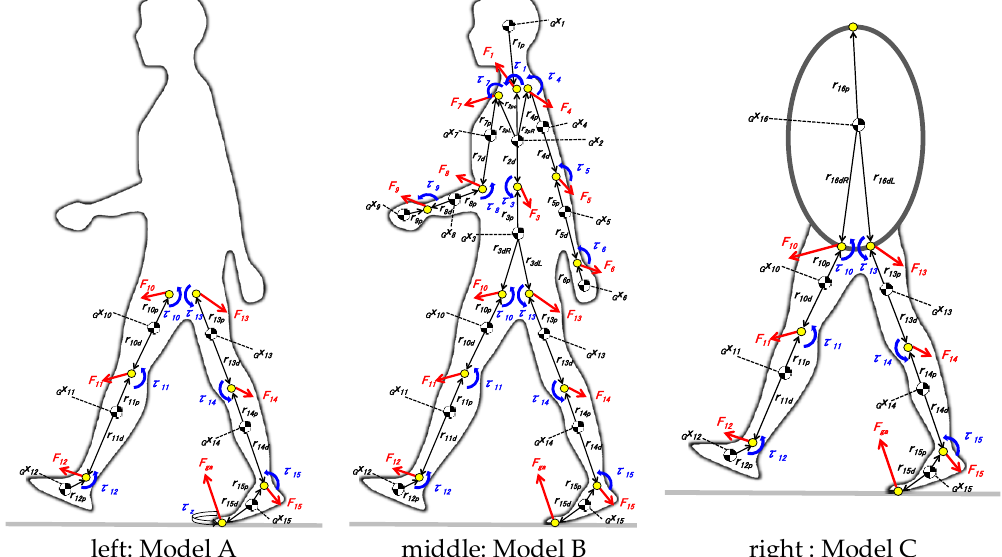
Figure 1. Rigid body linked segment